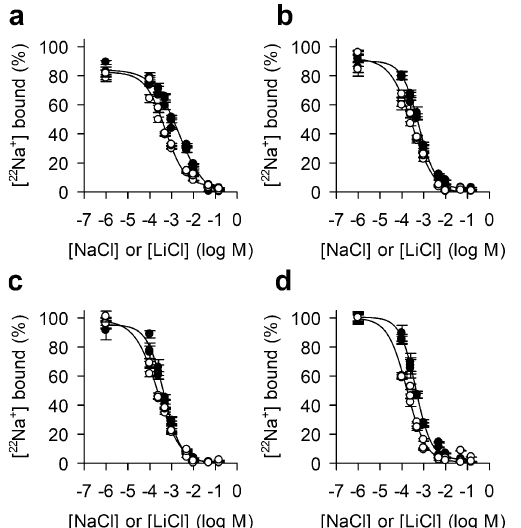
Figure 3. The dependence of the apparent binding affinities of Na + and Li + on the experimental conditions. The apparent binding affinities of Na + (solid symbols) and Li + (open symbols) were determined by isotopic displacement of 50 µM [ 22 Na]Cl (50 Ci mol −1 ) bound to 200 ng NhaA-WT with increasing concentrations of Na + NaCl (yielding the EC 50 ) or by displacing bound 50 µM [ 22 Na]Cl (50 Ci mol −1 ) with increasing concentrations Li + of LiCl (yielding the IC 50 ). The assay was performed in buffer containing ( a ) 0.1% (w/v) DDM, ( b ) 0.015% (w/v) DDM, ( c ) 0.1% (w/v) DDM plus 5% (w/v) cardiolipin, or ( d ) 0.015% (w/v) DDM plus 5% (w/v) cardiolipin. Data of three independent experiments (presented as mean ± s.e.m.) were subjected to global nonregression fitting and the data of the fits are shown in Table